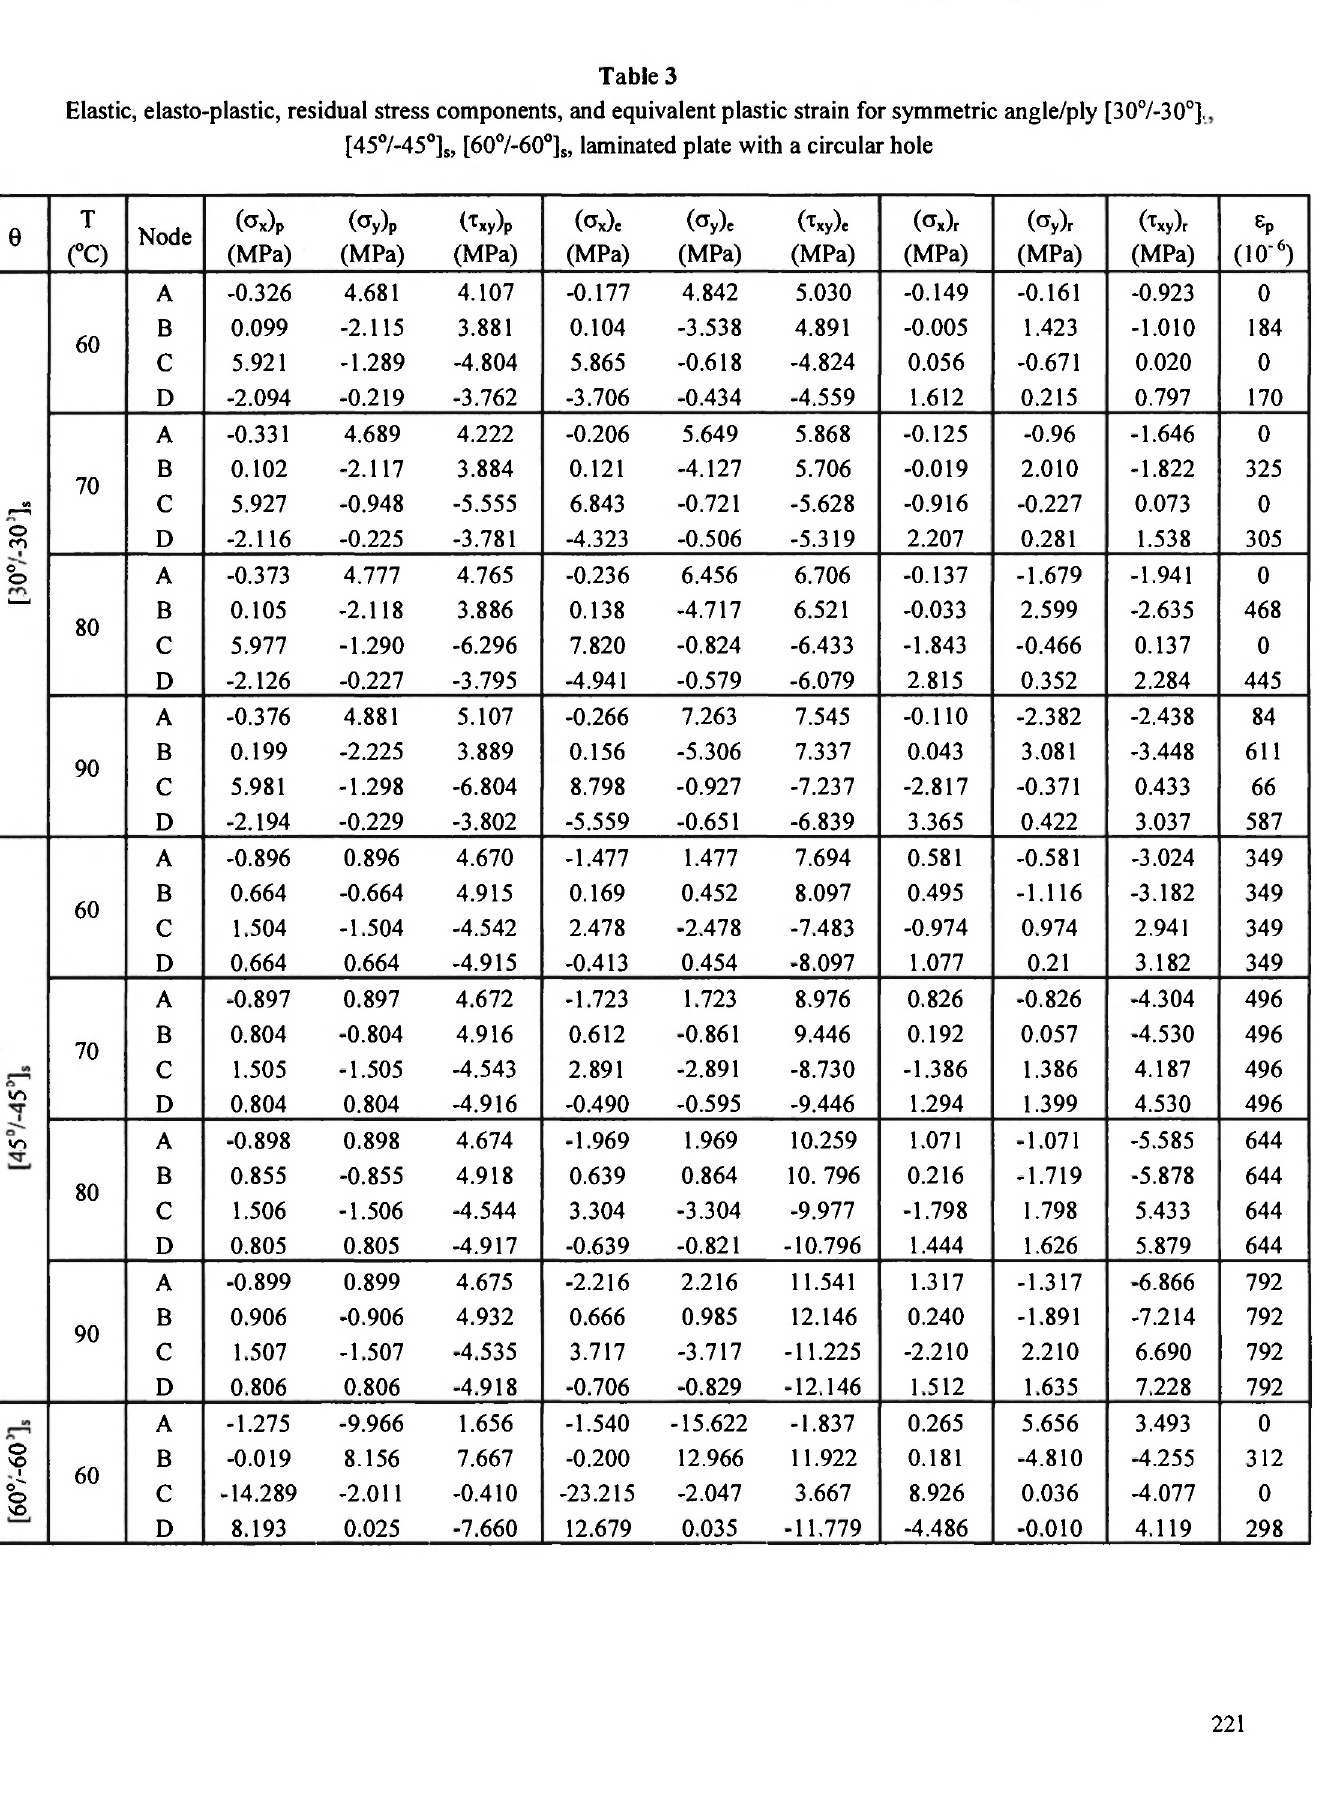
Elastic, elasto-plastic, residual stress components, and equivalent plastic strain for symmetric angle/ply